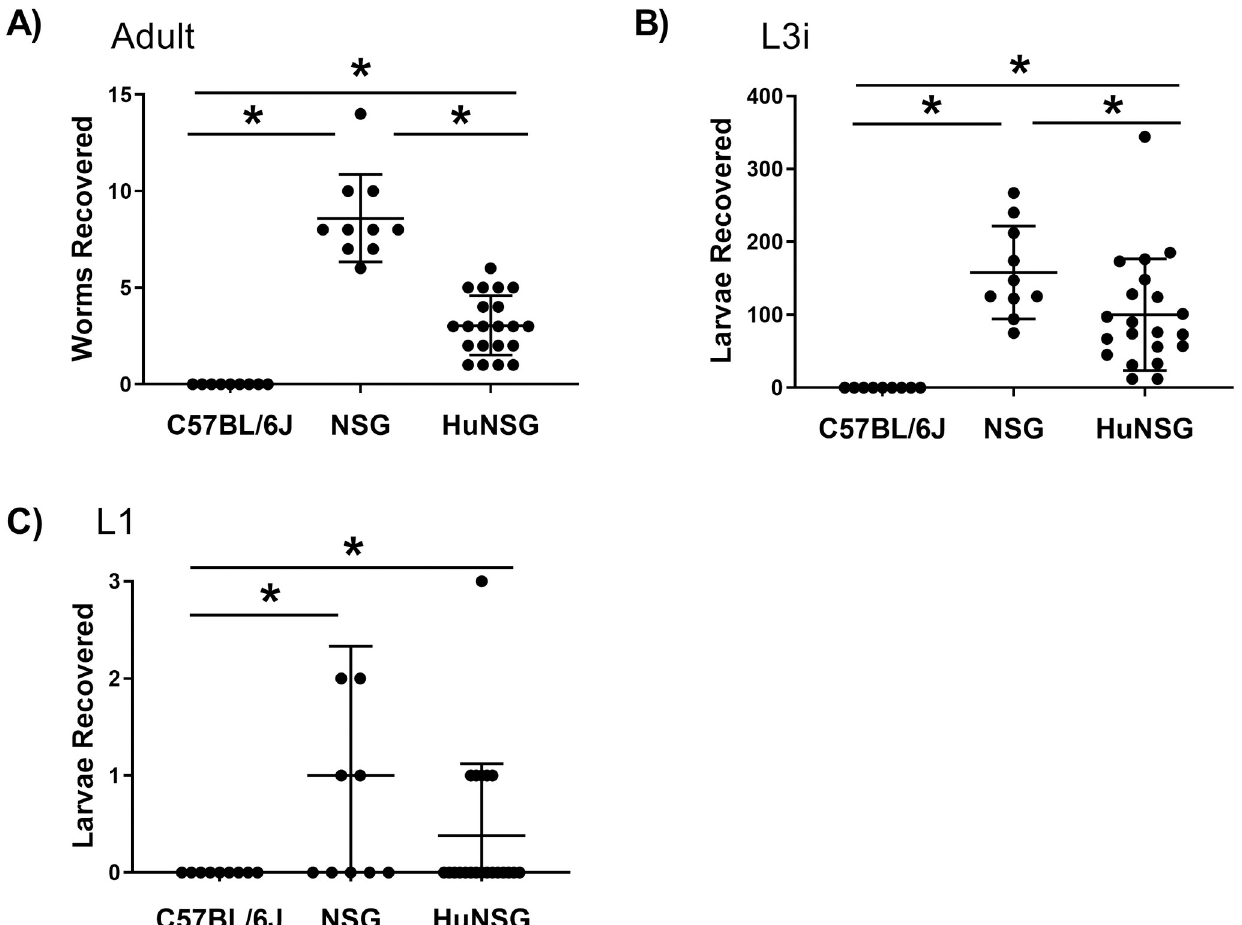
Fig 2. C57BL/6J, NSG and humanized NSG mice were infected with 500 infective third-stage larvae (L3i) of Strongyloides stercoralis weekly for 4-weeks to determine susceptibility of the mice to the infection. Adults (A), L3i (B) and first stage larvae (L1) (C) were collected and counted. Data presented are means ± standard deviations and asterisk represents p <